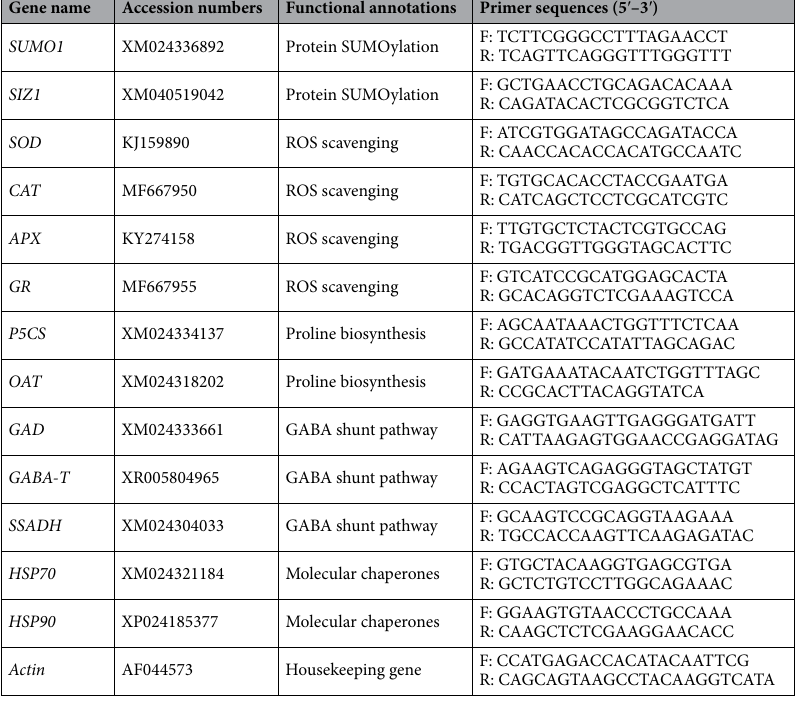
Table 1. Primers used for